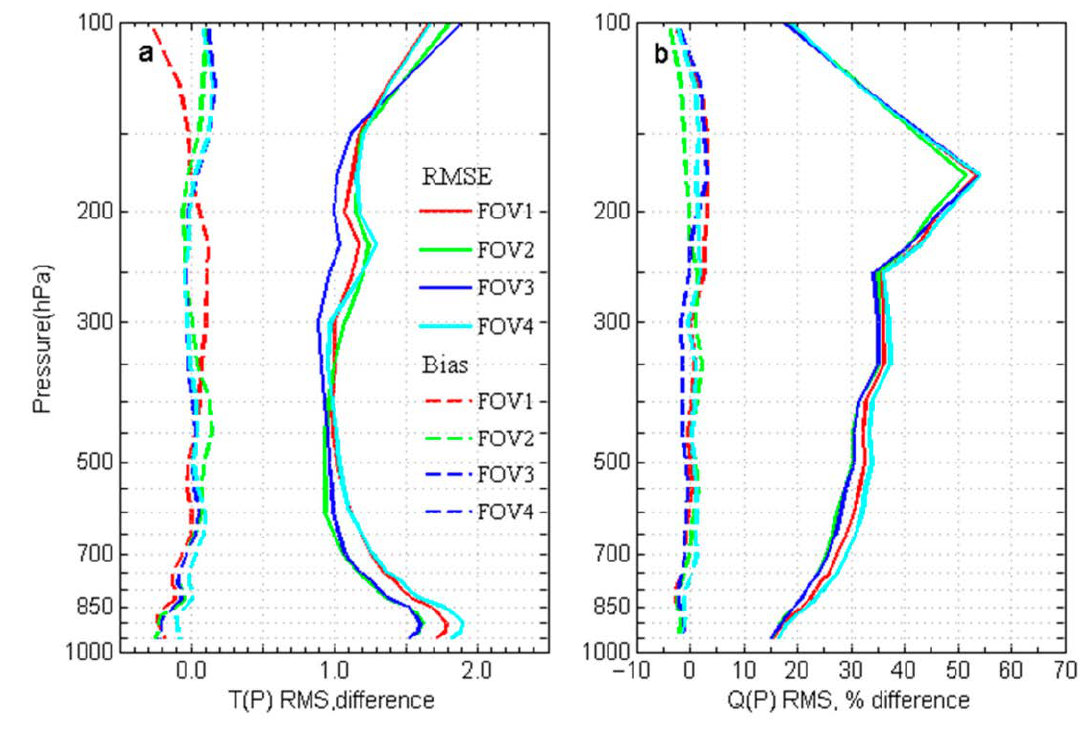
Figure 11. The RMSE and bias of temperature ( a ) and relative humidity ( b ) profiles between the retrieval results and the ERA5 data for different FOVs.